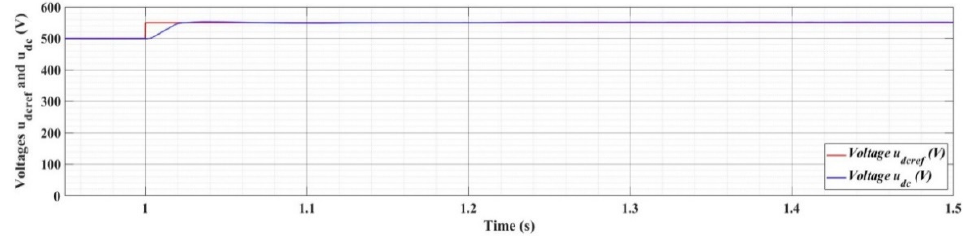
Figure 48. The time evolution of voltage u dc for a step variation of the u dcref reference voltage from 500 V to 550 V using SMC- and SYN-type controllers and the RL-TD3 agent for the correction of the u dref and u qref commands (signal evolution of the type 2 PV array).